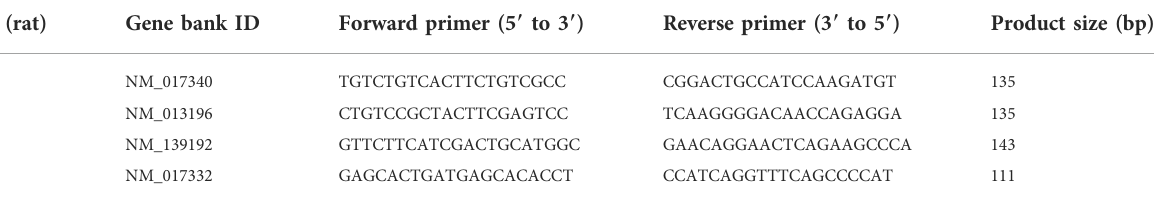
TABLE 1 Primers used for qPCR.